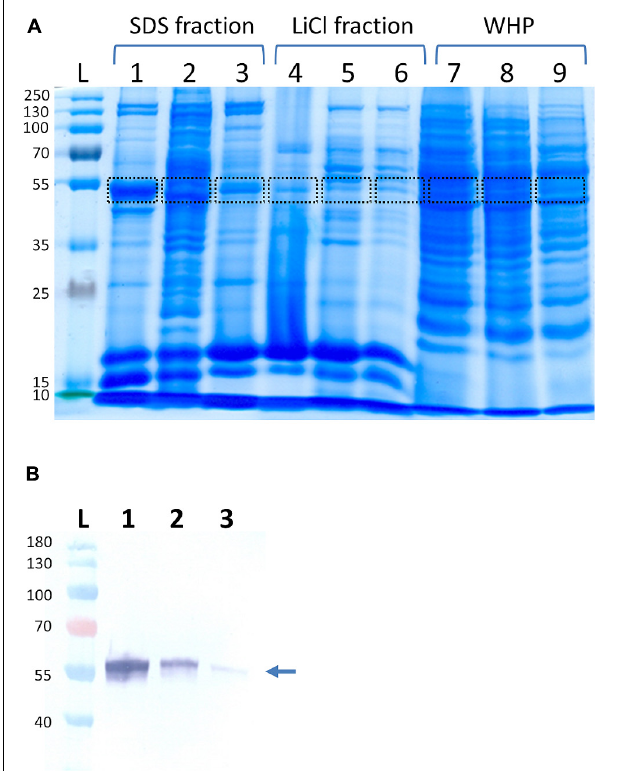
FIGURE 1 | Identification of Staphylococcus lugdunensis enolase in different protein extracts. (A) S. lugdunensis strains Sl20 (lanes 1, 4, 7), Sl44 (lanes 2, 5, 8), and SF48 (lanes 3, 6, 9) were cultivated overnight in brain heart infusion (BHI) medium at 37 ◦ C and aerobic condition with a continuously agitation. The bacteria were pelleted by centrifugation, and cell surface-associated proteins were extracted by heating the bacteria in 2% SDS containing sample buffer at 95 ◦ C for 3 min (SDS fraction) or stirring in 1 M LiCl (LiCl fraction). Whole-cell proteins (WHP) were generated by lysis of bacterial cells with lysostaphin and lysozyme. Bands were cut and identified by MALDI-TOF-MS/MS. Marked bands correspond to fractions containing the enolase. Lane L, ladder with size information in kDa; lanes 1–3, SDS-extracted cell surface proteins; lanes 4–6, LiCL-extracted cell surface proteins; lanes 7–9, whole-cell proteins. Shown is one out of three biological replicates. (B) Western blot analyses of enolase using LiCl generated cell surface protein extracts (1), cell wall extracts (2), and the cytoplasmic protein fraction (3) of S. lugdunensis . The respective protein fractions were separated using SDS page, transferred to nitrocellulose membranes and, after blocking the membranes, incubated with anti-SlEno rabbit antibodies. The arrow shows the band corresponding to the enolases.